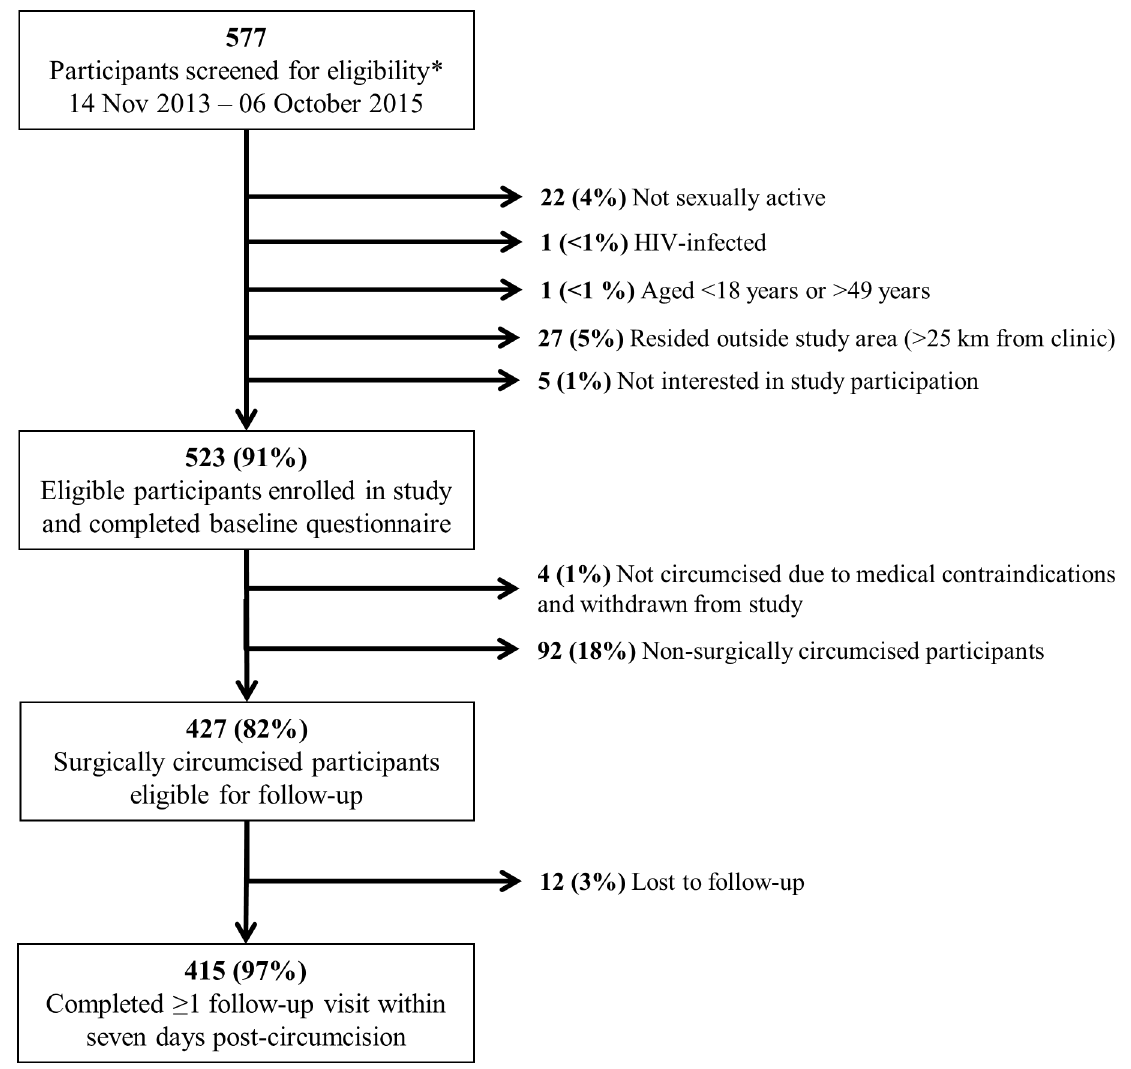
Fig 1. Flow chart of N = 577 men screenedfor circumcision eligibility within the National Safe Male Circumcision program in Gaborone, Botswana. Two participantsdid not meet two eligibilitycriteria and thus the numberand percentages presented for individualreasonsfor ineligibilitysum to >